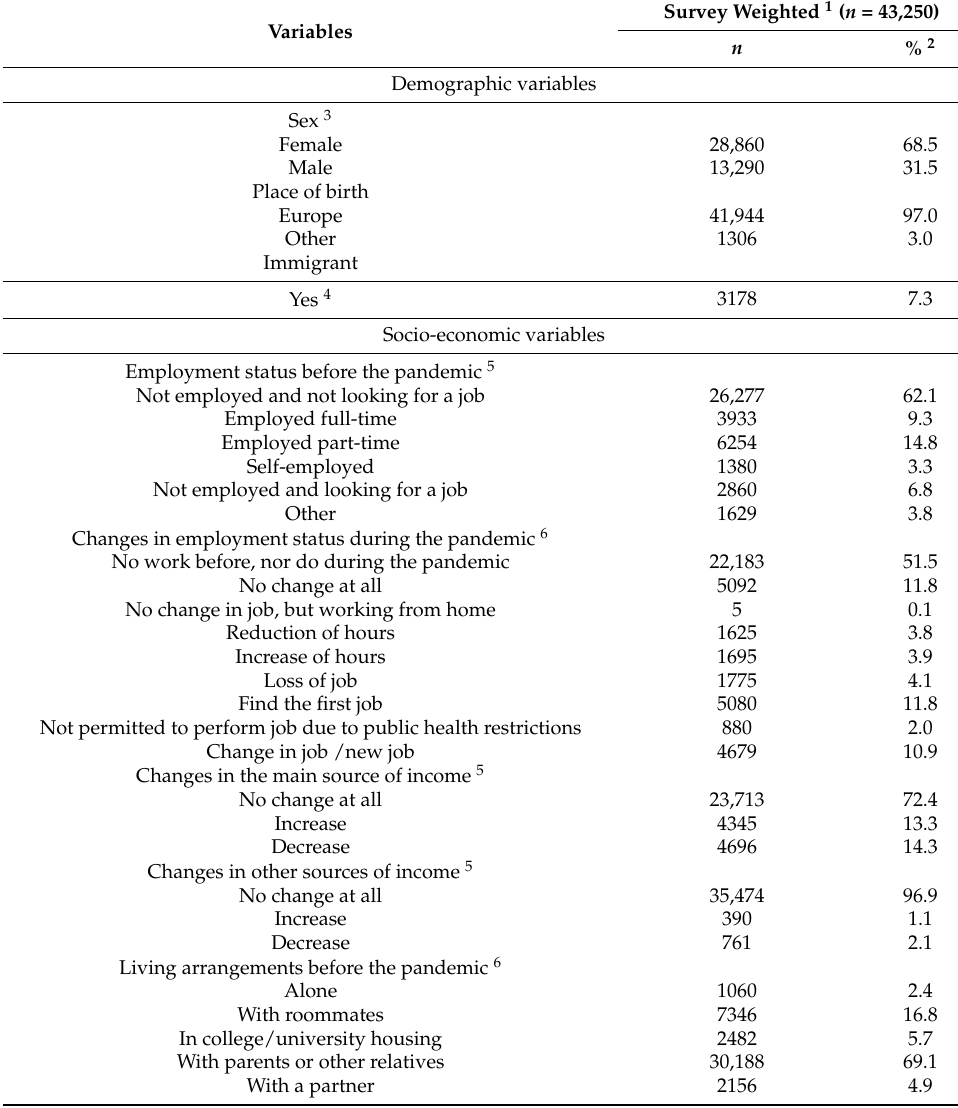
Table 1. Demographic and socio-economic characteristics of the sample: students of the University of the Basque Country